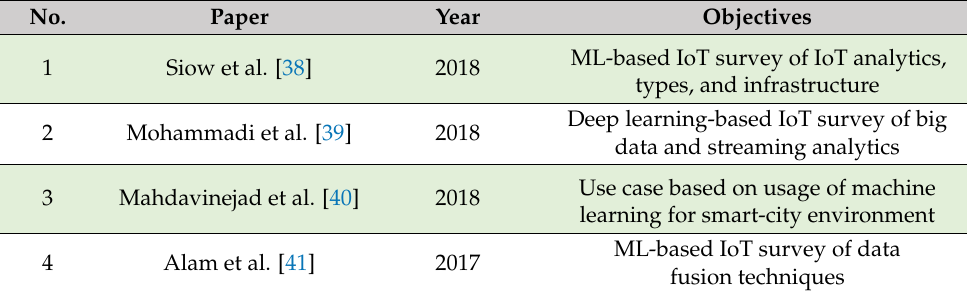
Table 1. Major machine learning-based IoT surveys.